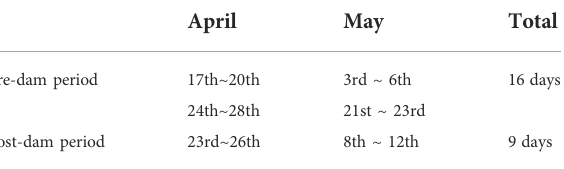
TABLE 4 Comparison of continuous water rise duration before and after dam construction at the Xiaolangdi Reservoir on the Yellow River, China.